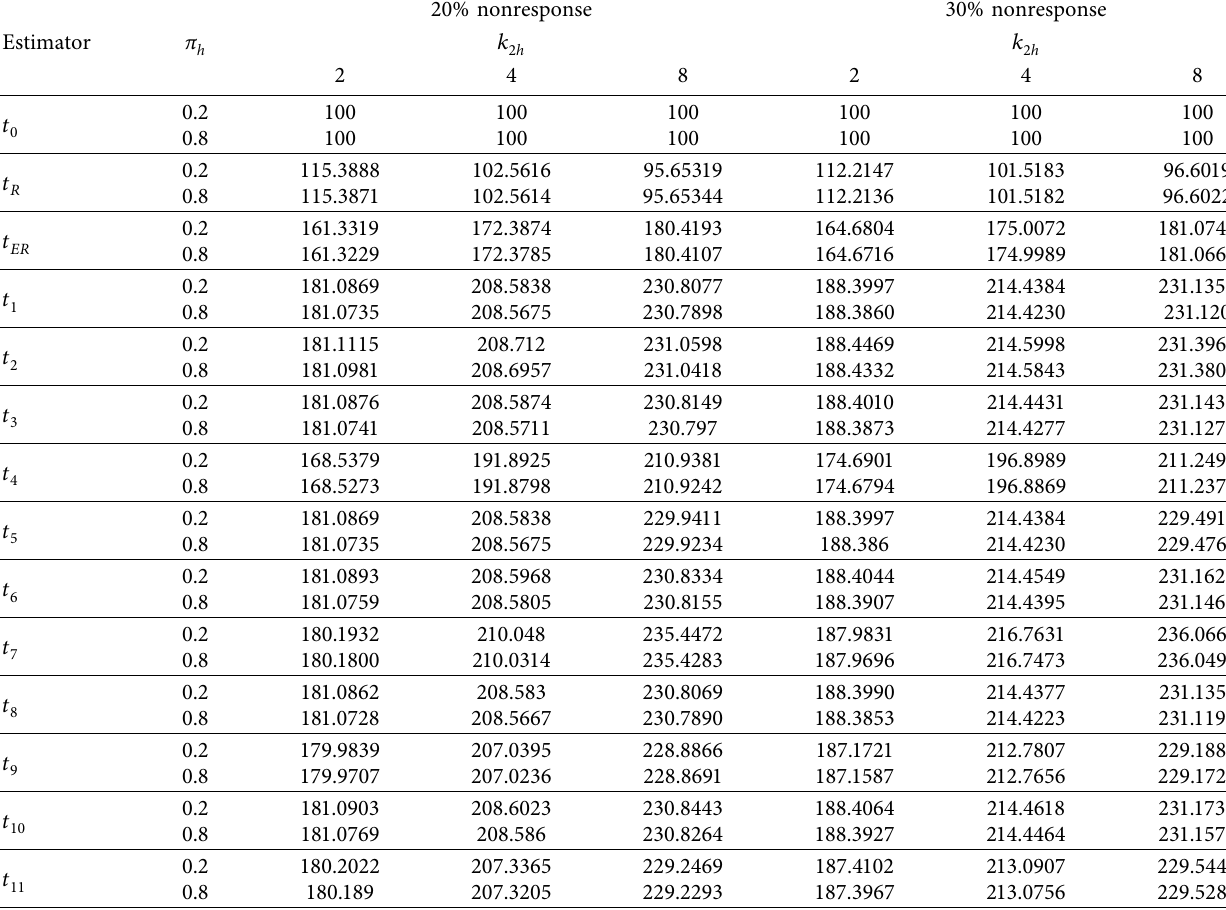
Table 5: PREs of different mean estimators for population I.